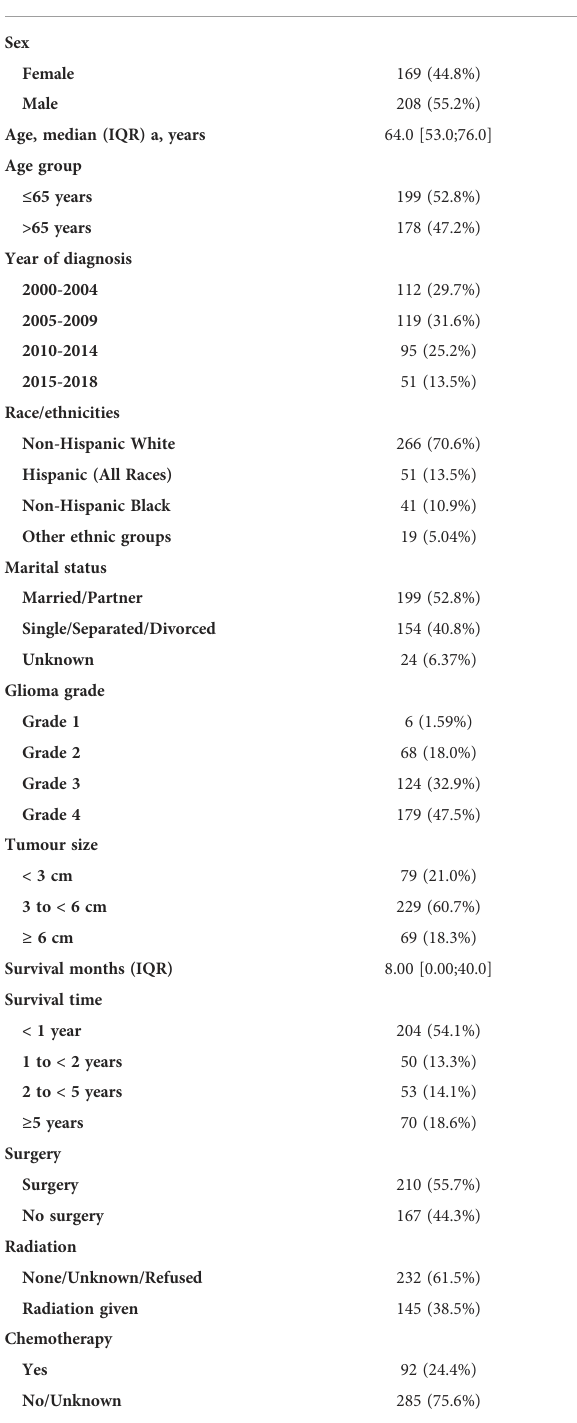
TABLE 2 Cerebrovascular death in patients with gliomas SEER 2000- 2018.